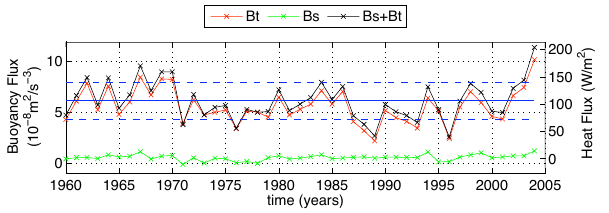
dicated are the ones in which the winter starts), Bt (red) and Bs (green). The blue line shows the average winter buoyancy fluxes while the dashed blue lines show the mean plus or minus a standard deviation.